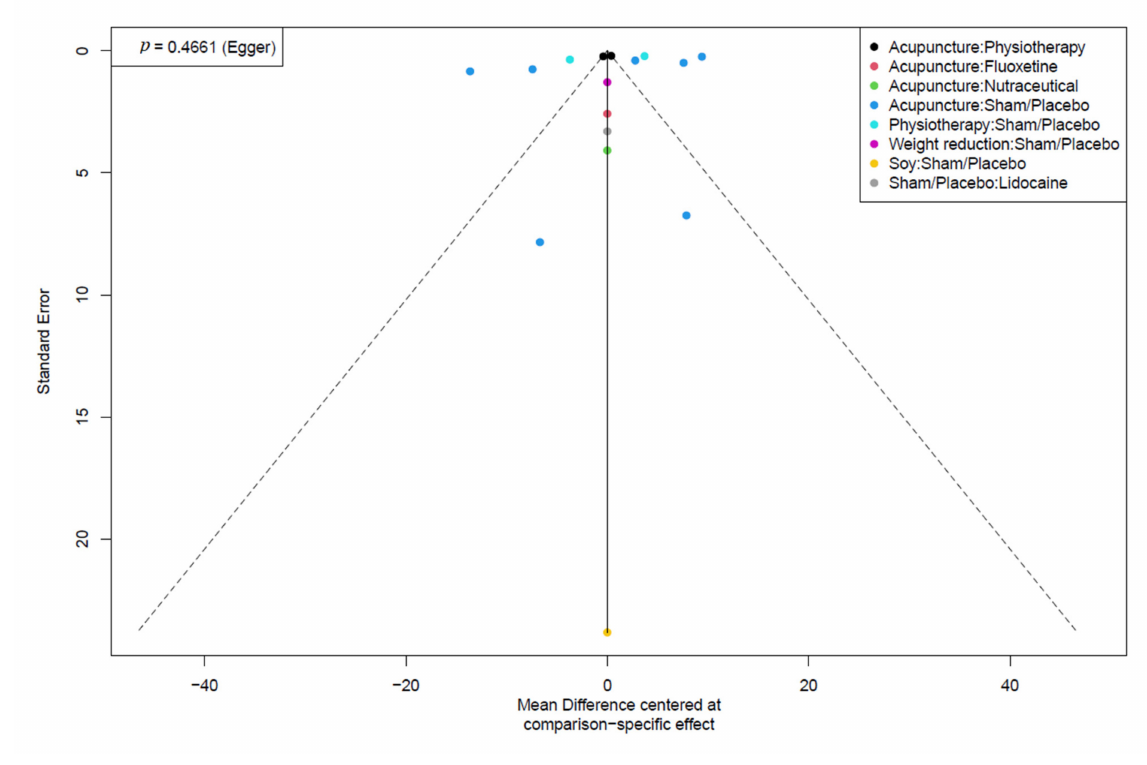
Figure 7. Funnel plot of the QoL outcome.